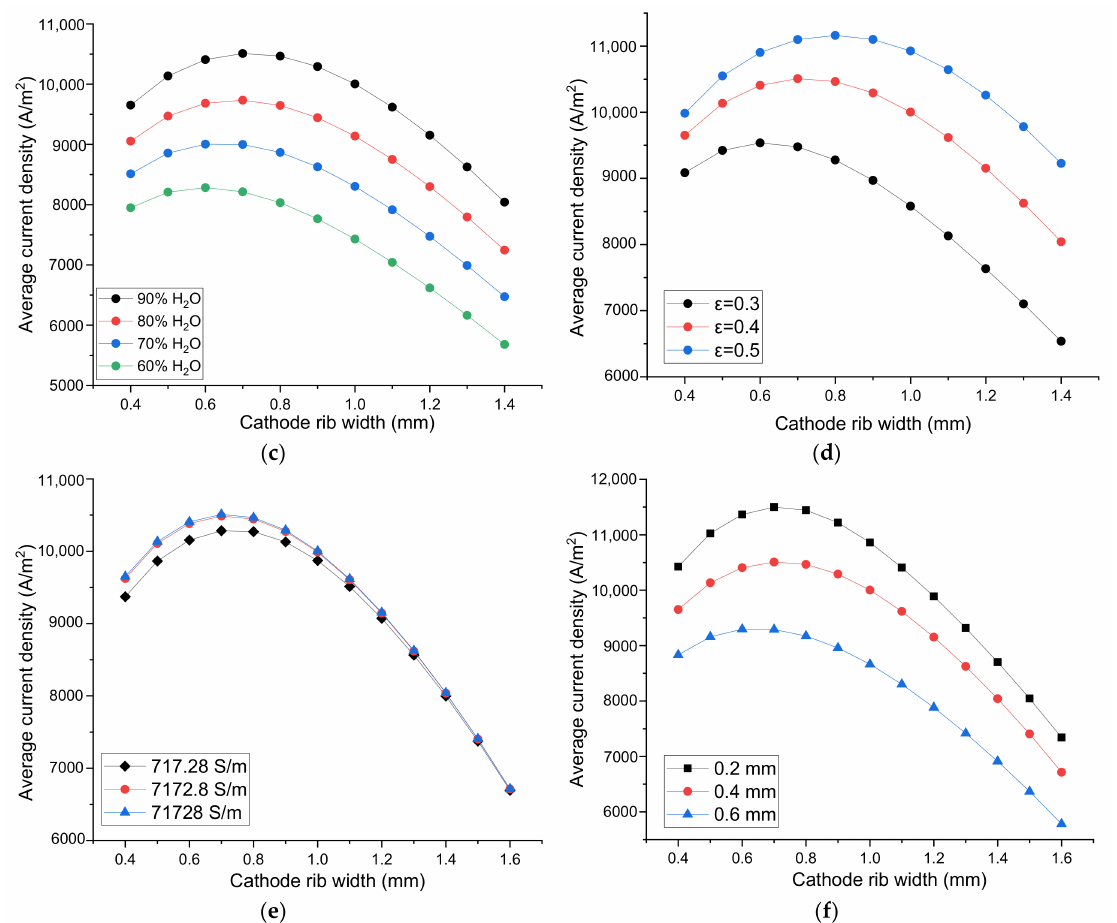
Figure 3. The e ff ect of rib width on the SOEC performance. Parameter on the O 2 electrode side: ( a ) the rib / pitch ratio, ( b ) the rib-electrode ASR. Parameter on the H 2 electrode side: ( c ) Inlet H 2 O content, ( d ) Electrode porosity, ( e ) Electrode conductivity, ( f ) Electrode